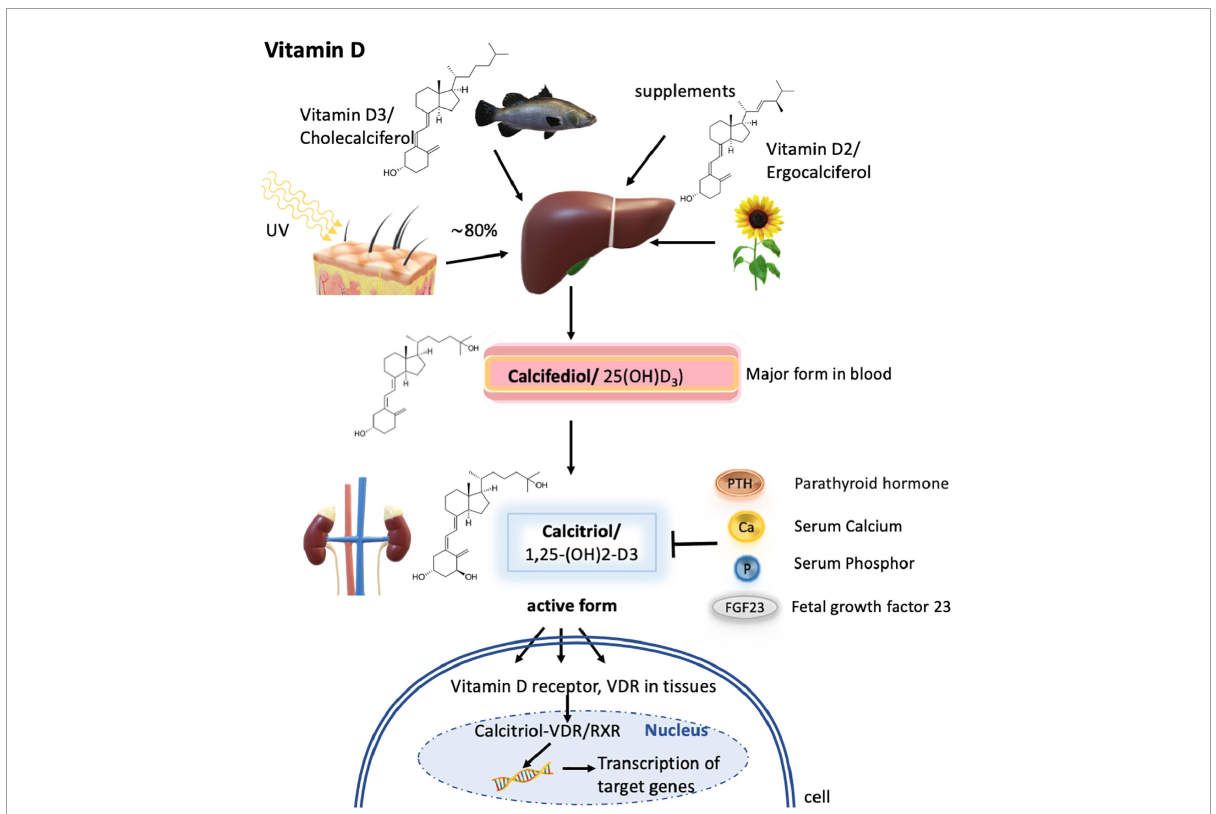
FIGURE4 Vitamin D metabolism. Vitamin D3 is synthesized mainly in the skin by UV radiation, but a small fraction can also be obtained via diet as vitamin D3 or vitamin D2. In the liver, both forms are metabolized to calcifediol (by CYP27A1), which is the major form present in the blood but is not biologically active. Only upon further hydroxylation in the kidney, calcifediol is turned into its active form termed calcitriol. Calcitriol synthesis is known to depend on calcitriol itself, the parathyroid hormone, serum calcium concentrations, serum phosphor concentrations, and fetal growth factor 23. The active form then subsequently binds to the vitamin D receptor (VDR) expressed in different tissues, which then enters the nucleus to form heterodimers with the retinoid X receptor/RXR and activates the transcription of calcitriol target